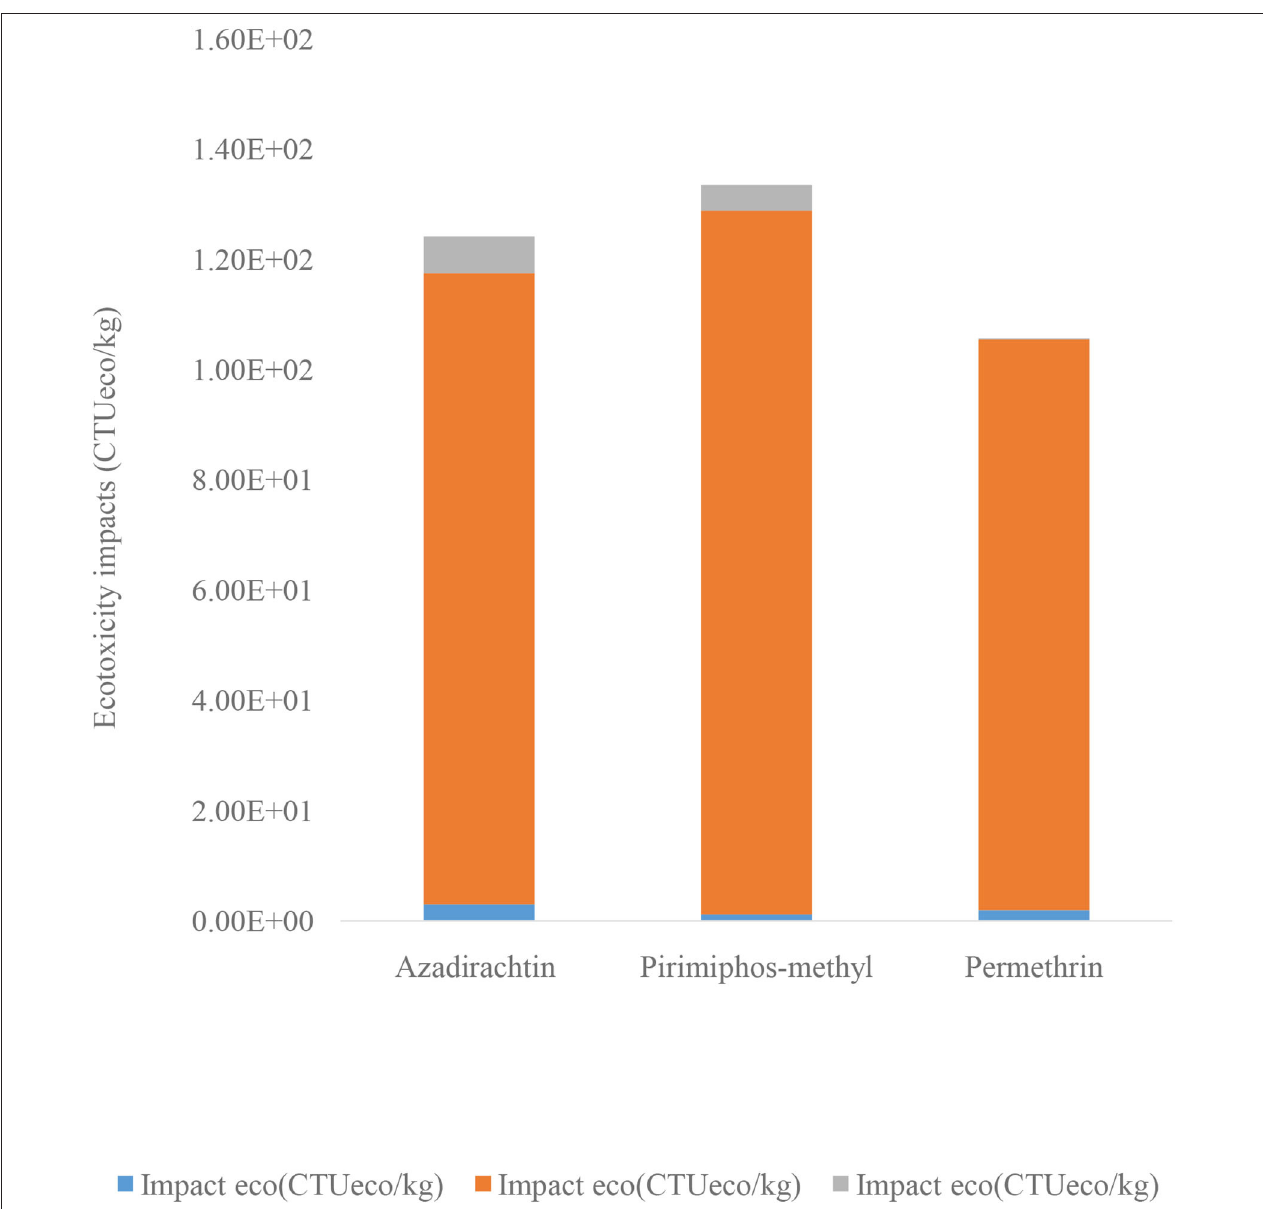
FIGURE 3 | Ecotoxicity impacts of azadirachtin, pirimiphos-methyl, and permethrin usage on air, water, and soil per 1kg of maize grain (generated using TRACI database, version 2.1,